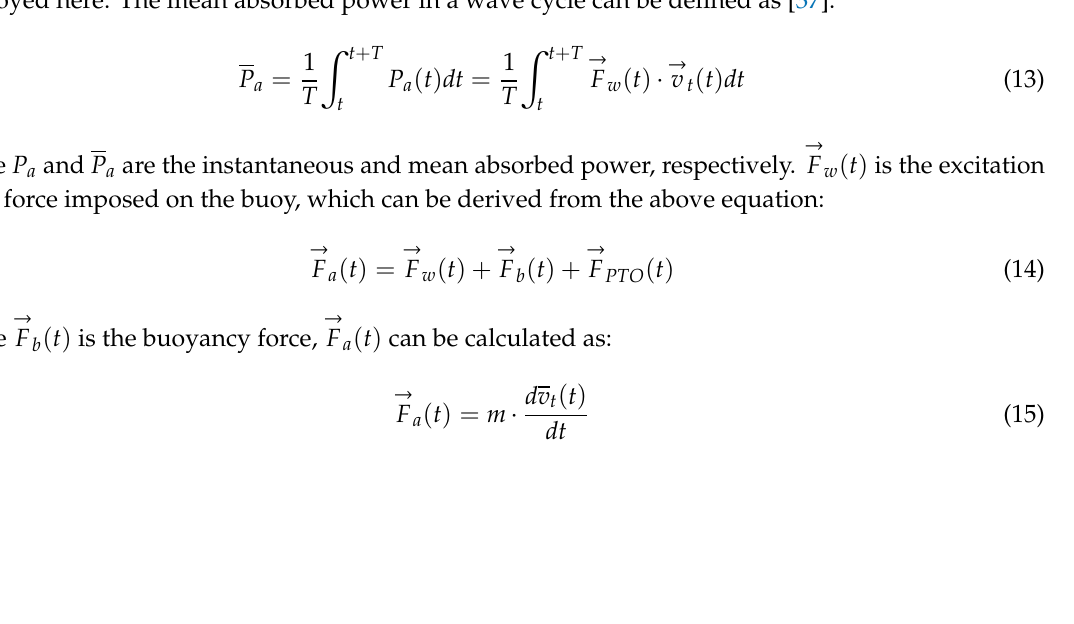
Figure 20. Effects of PTO coefficient on hydrodynamic performance of the buoy ( H = 0.1 m).